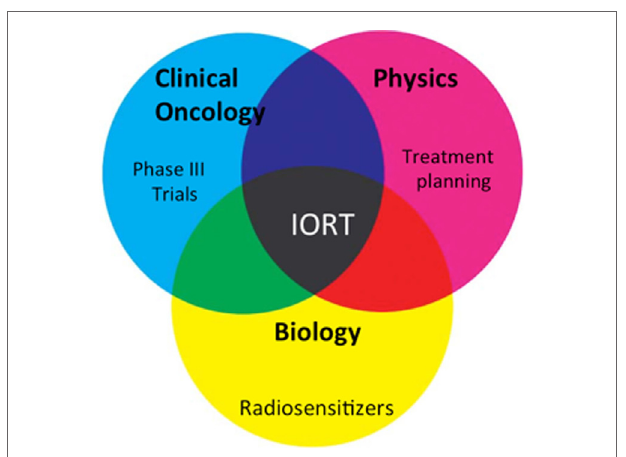
FiGURe 1 | Summary of future directions. Phase III trials (clinical), treatment planning (physics), and radiosensitizers (biology) are at the forefront of current intraoperative radiation therapy research